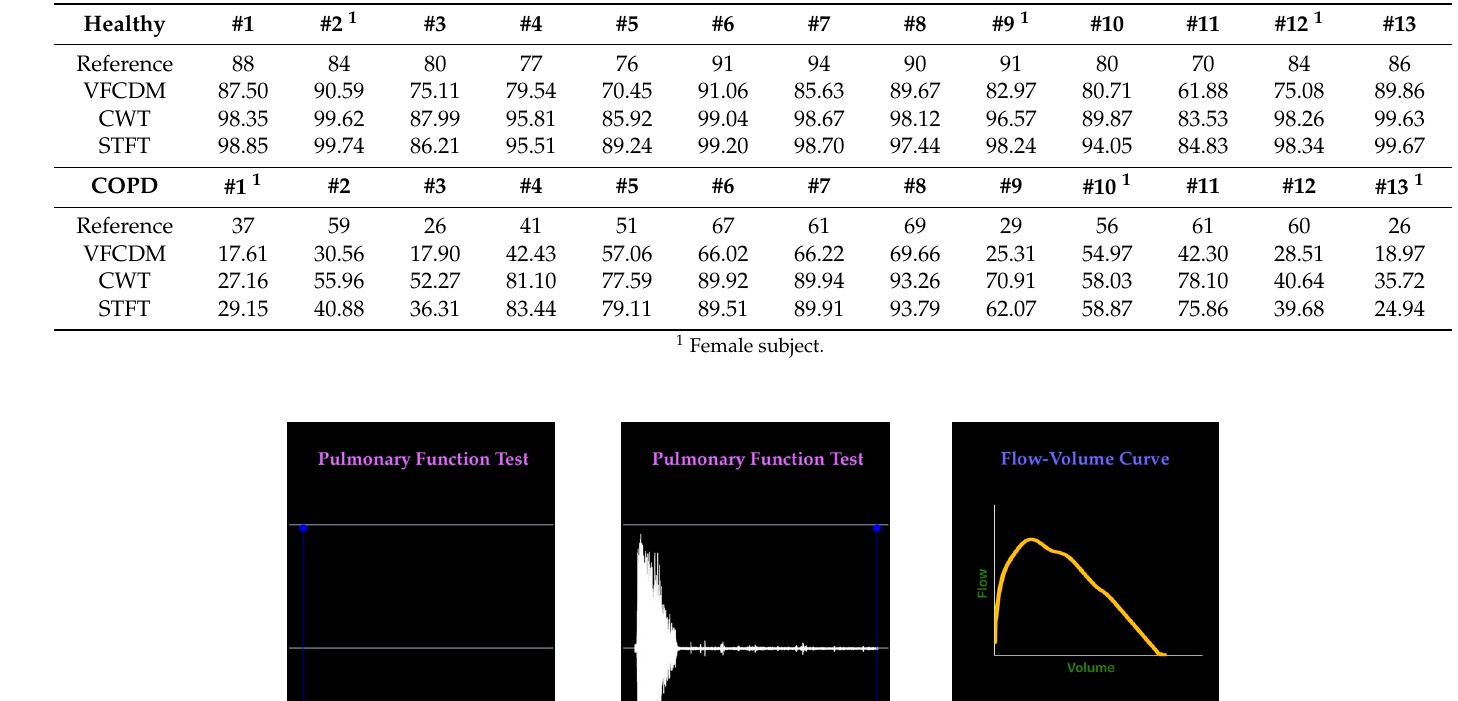
Figure 7a–d show the regression plots based on VFCDM for FEV 1 /FVC, FVC, FEV 1 , and PEF,